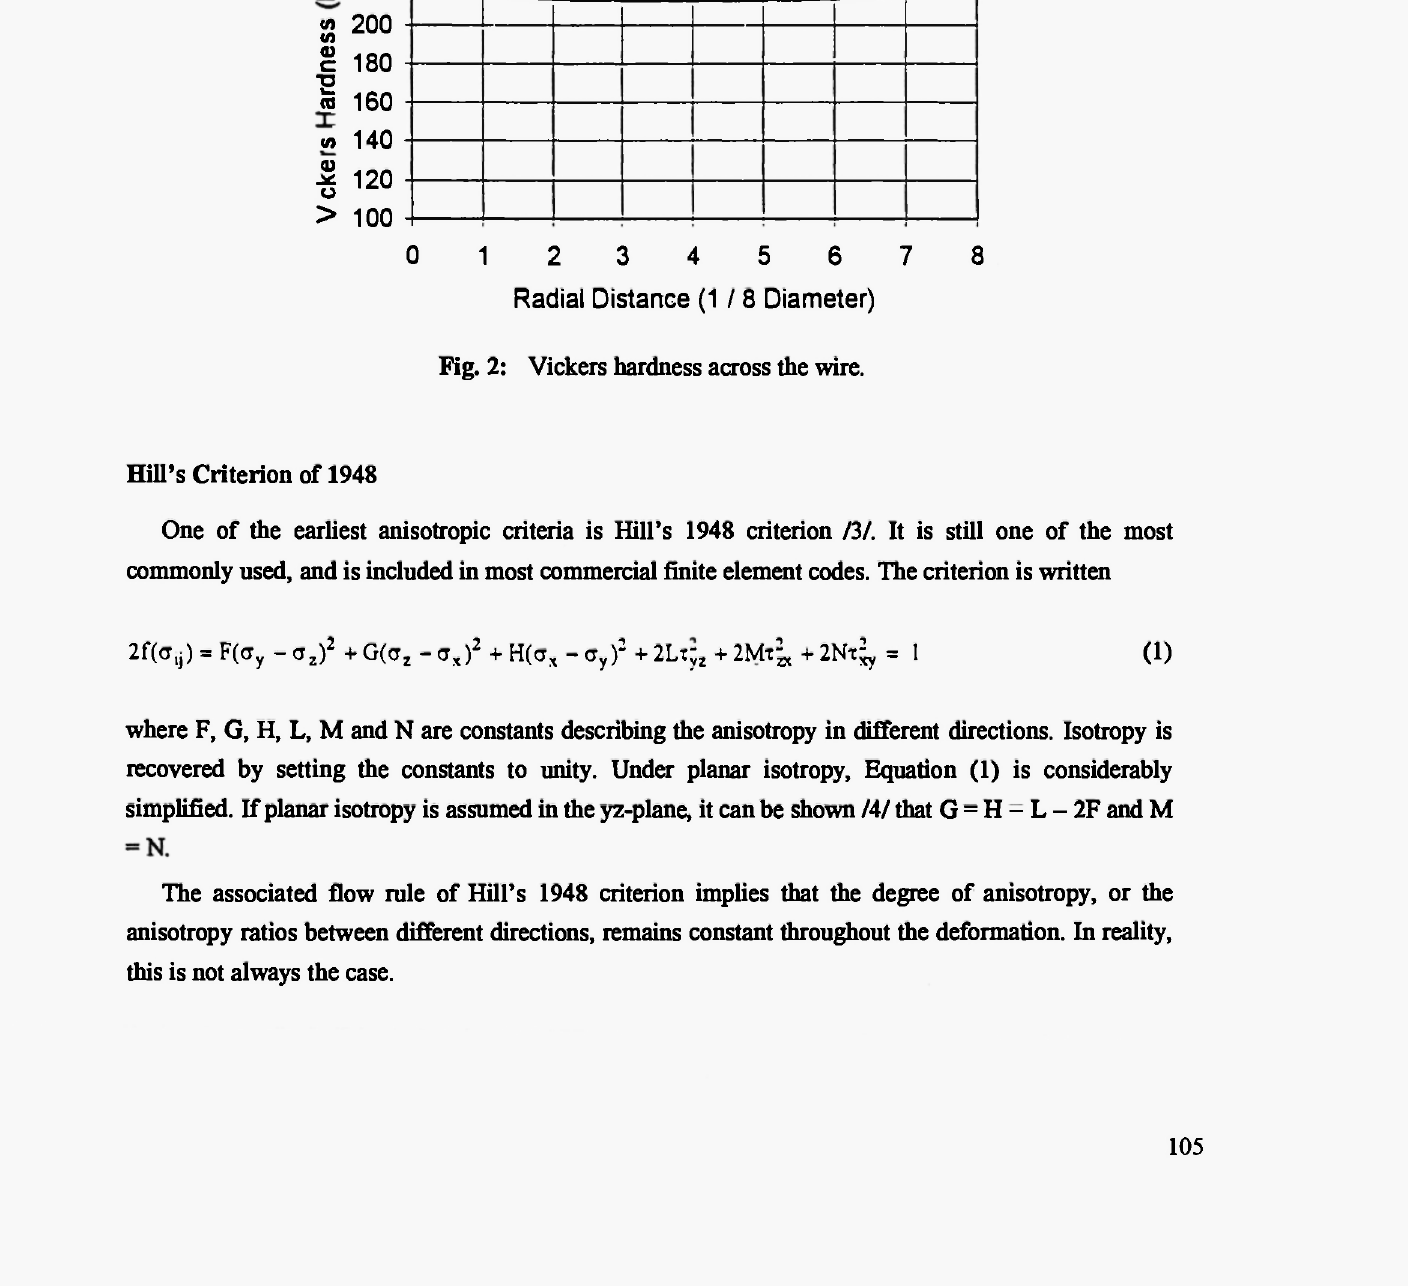
Fig. 2: Vickers hardness across the